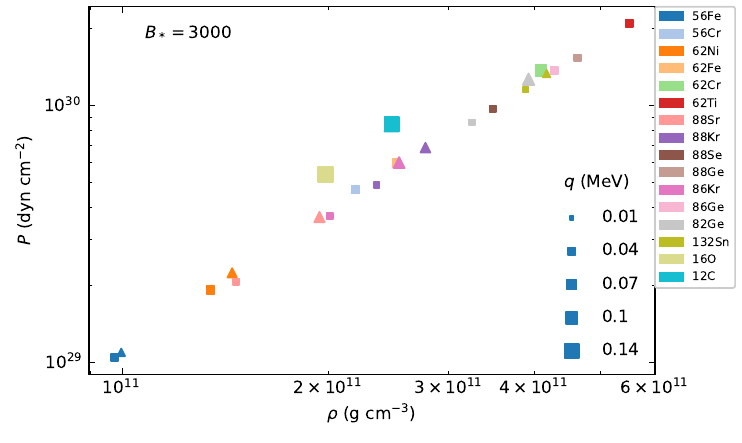
Figure 4. Same as Figure 3 for B (cid:63) = 3000. As expected, transitions from the ground state of the parent nucleus to the first excited state of the daughter nucleus are more exothermic than ground-state-to-ground-state transitions. Moreover, the heat released from electron captures by odd nuclei is